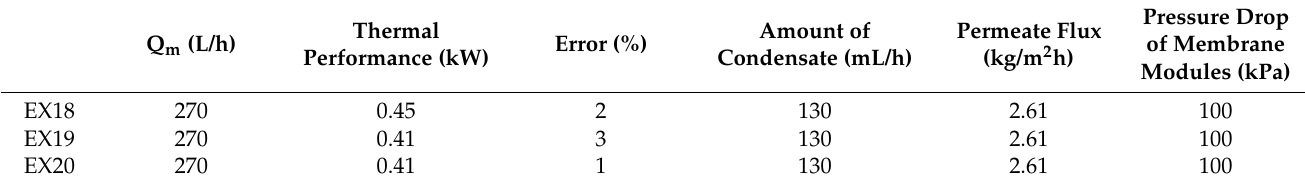
Table 11. Thermal performance, measurement error, condensate amount, permeate flux, and membrane module pressure drop for MM002.